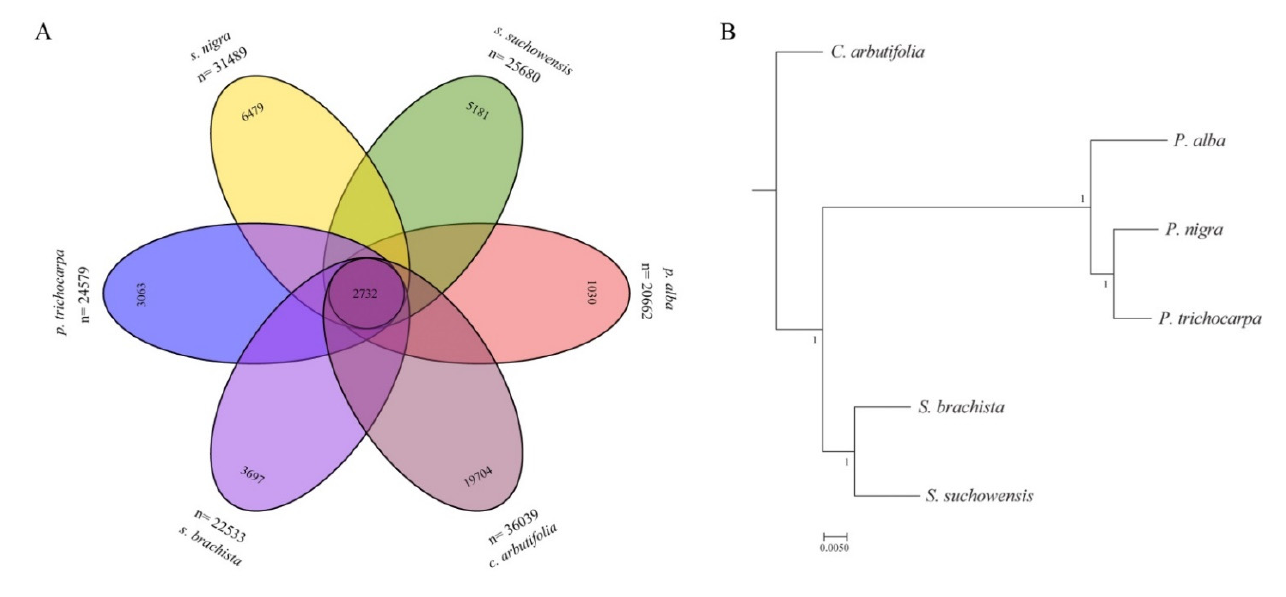
Figure 2. Analysis of orthologous genes in Chosenia arbutifolia and five other Salicaceae species. ( A ) Venn diagrams of orthologous genes. Numbers in middle circle represent total single-copy ortholog sequences for all six species. Numbers at interior edges of oval represent special orthogroups. Numbers outside oval represent total orthogroups. ( B ) Phylogenetic tree of Chosenia arbutifolia and five other Salicaceae species.